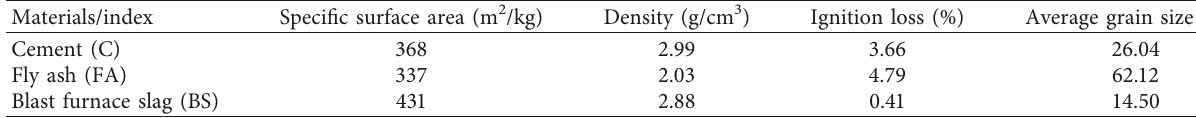
Table 2: Physical properties of cement and mineral admixtures.